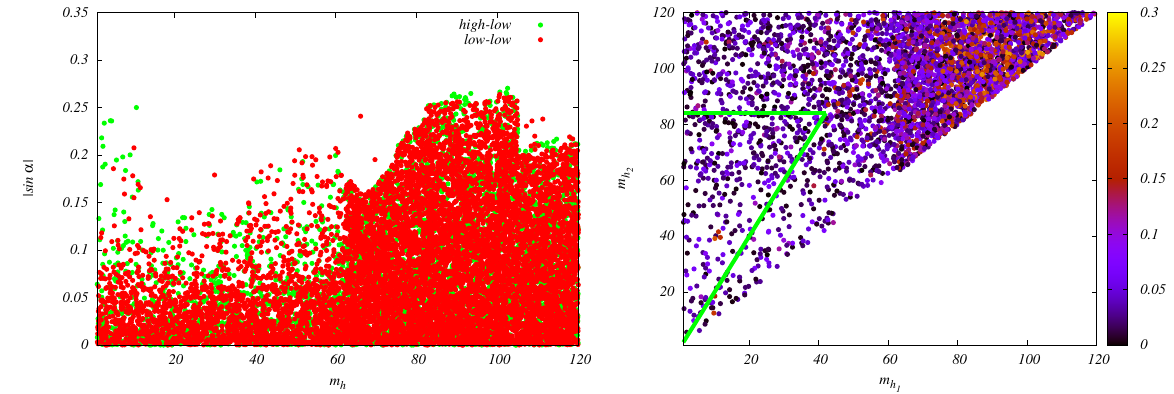
Figure 2. Available parameter space in the TRSM, with one (high-low) or two (low-low) masses lighter than 125 GeV. Left : light scalar mass and mixing angle, with sin α = 0 corresponding to complete decoupling. Right : available parameter space in the coding denoting the rescaling parameter sin α for the lighter scalar h 1 . Within the green triangle, h 125 h 2 h 1 h 1 h 1 h 1 decays are kinematically allowed. → →